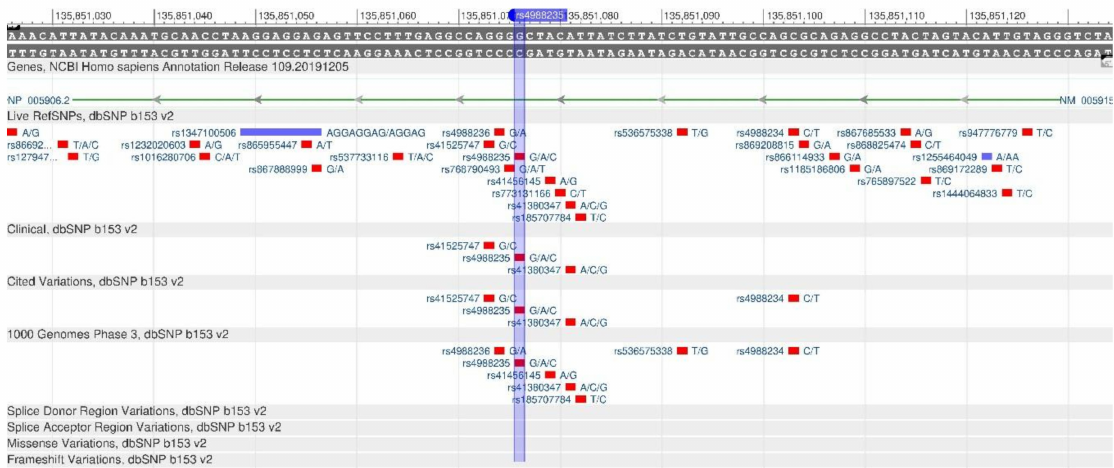
Figure 14. A portion of the MCM6 gene (located on the long (q) arm of chromosome 2) containing the oligonucleotide polymorphism rs4988235.